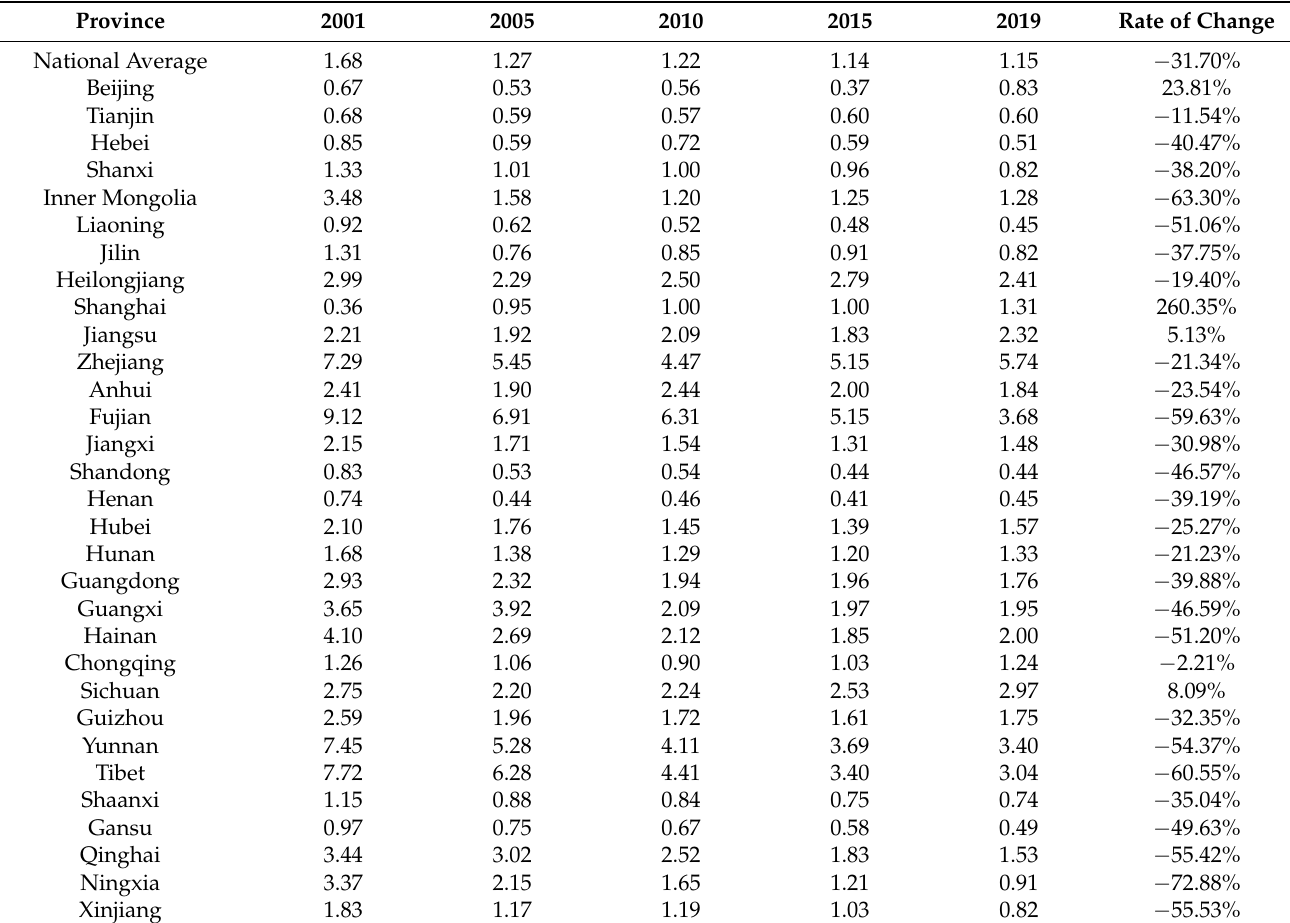
Table 3. Water resource carrying capacity and its change rate of animal husbandry in